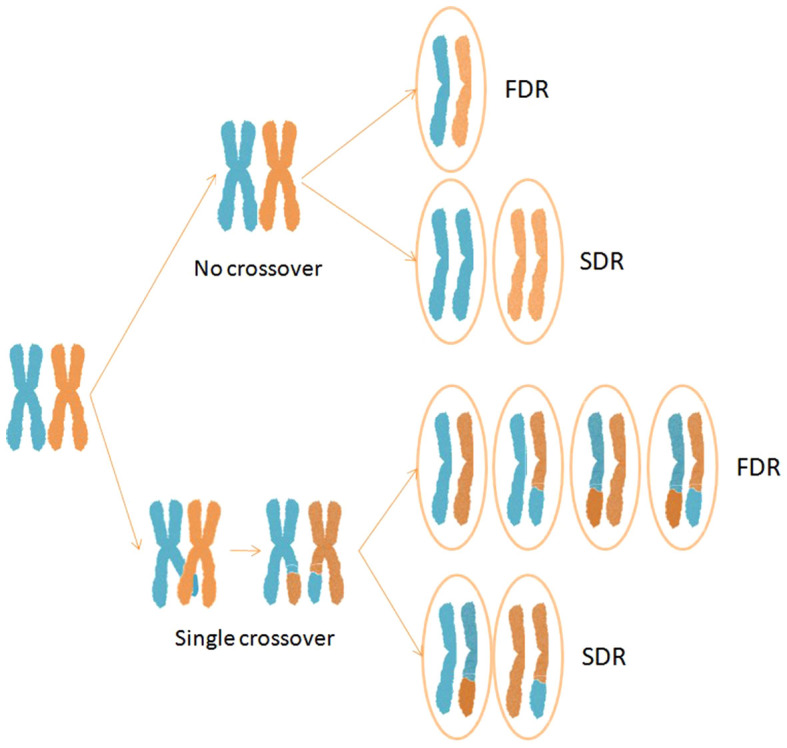
Half tetrads resulting from no crossover and single crossover events under FDR and SDR mechanisms of unreduced gamete formation.